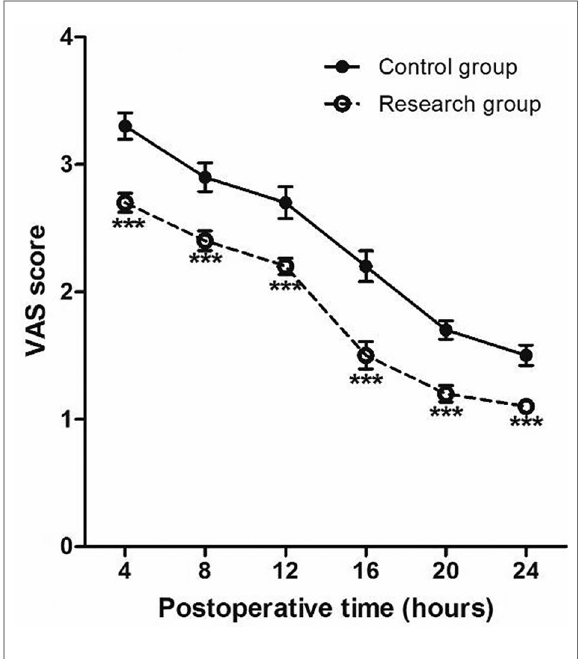
FIGURE 4 Perioperative VAS score at different time points. Compared with Control group, * P <0.05 and *** P